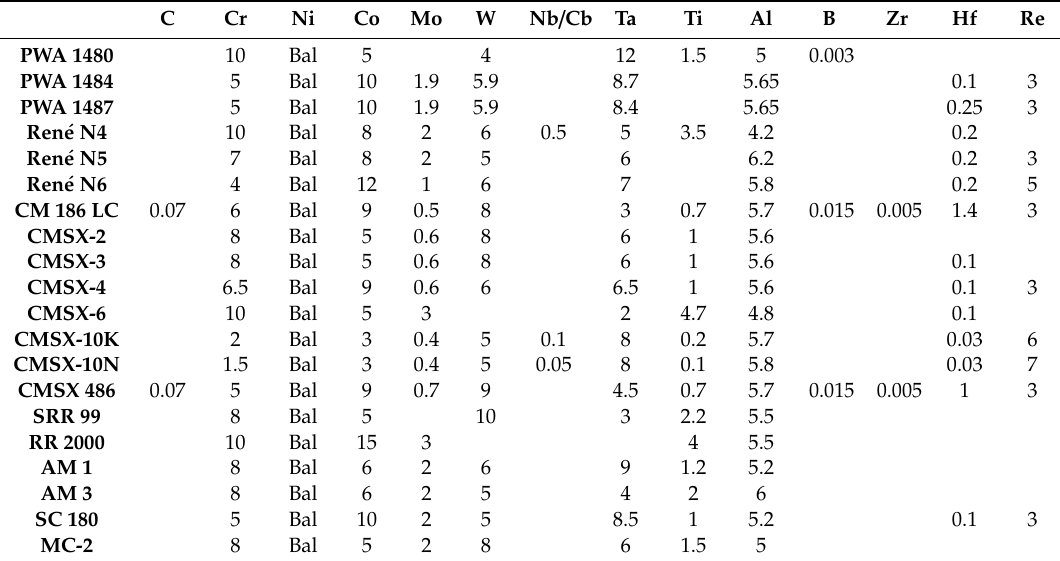
Table 1. Composition (wt.%) of a few popular nickel-base superalloys that are cast with SX microstructure (Obtained from